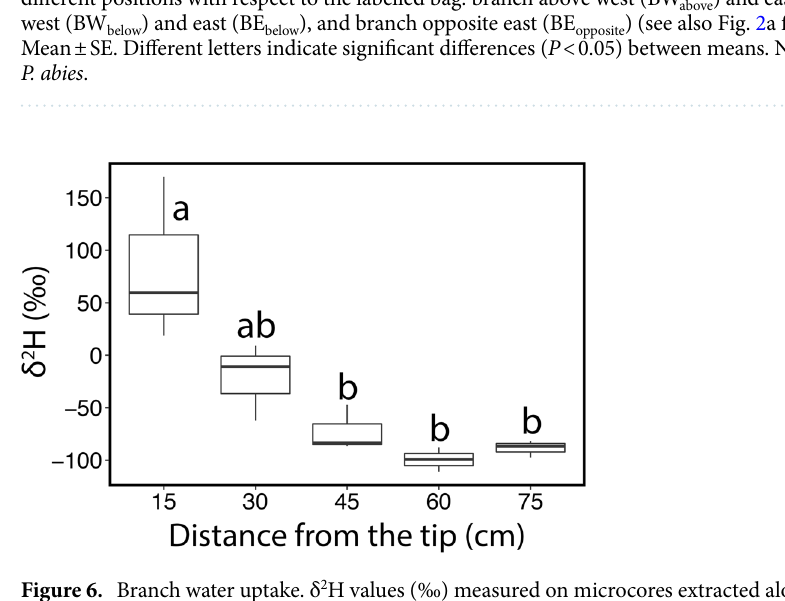
urements. Six trees per species (3 controls and 3 for the experiment) were selected for the labelling experiment during the seasonal course (see below) and four P. abies trees were selected for the branch water uptake experi-